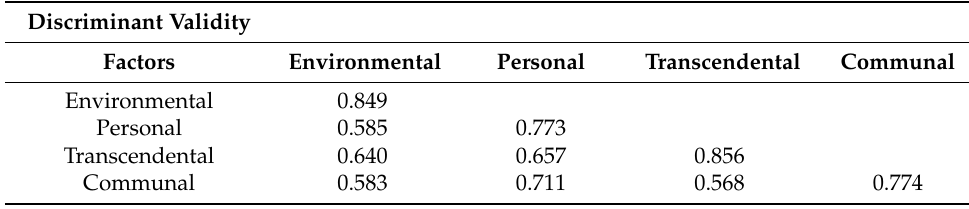
Table 5. Discriminant validity of the SWBQp